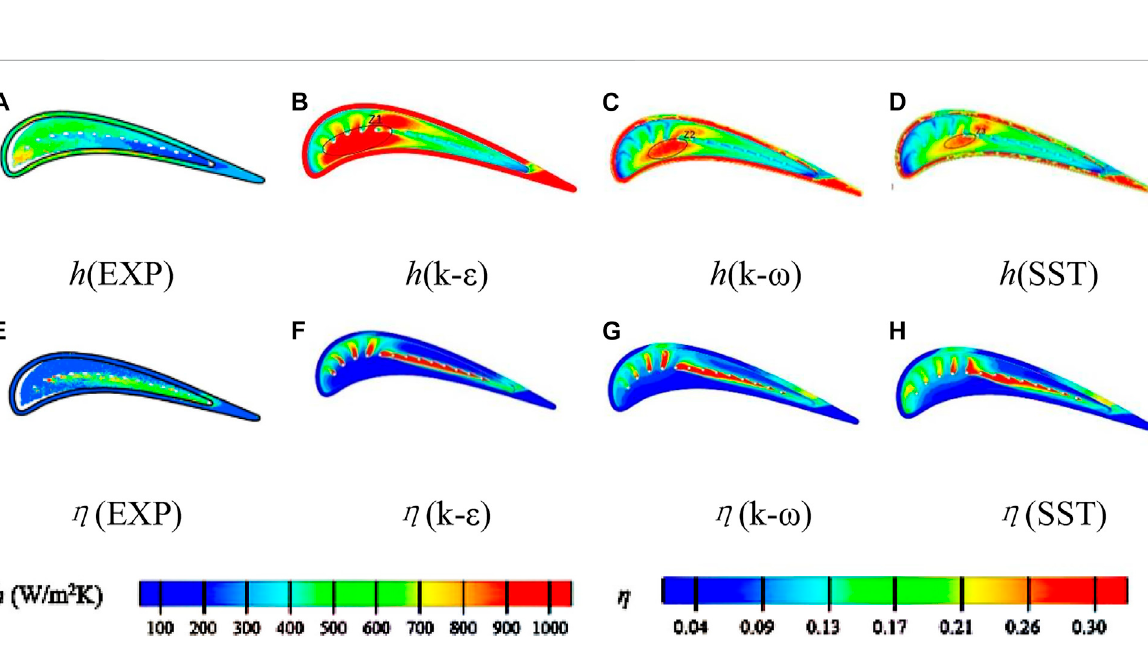
FIGURE 6 Thermodynamic veri fi cation: (A – D) h and (E – H) η comparison of the